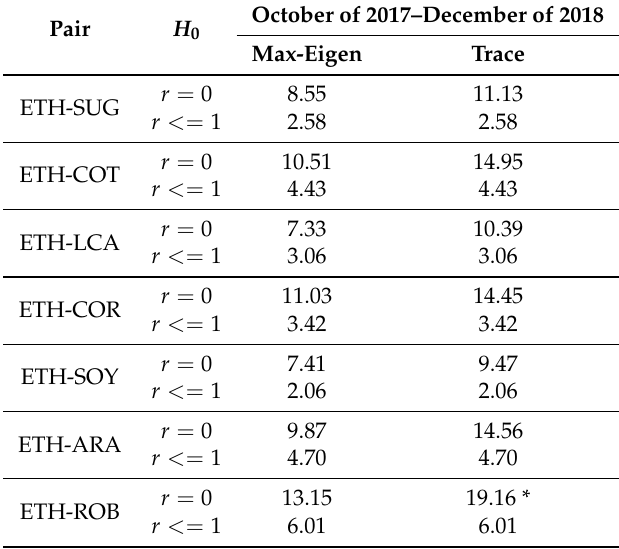
Table A6. The Johansen test for P 5 . Significance levels: 10% (*), 5% (**) and 1%